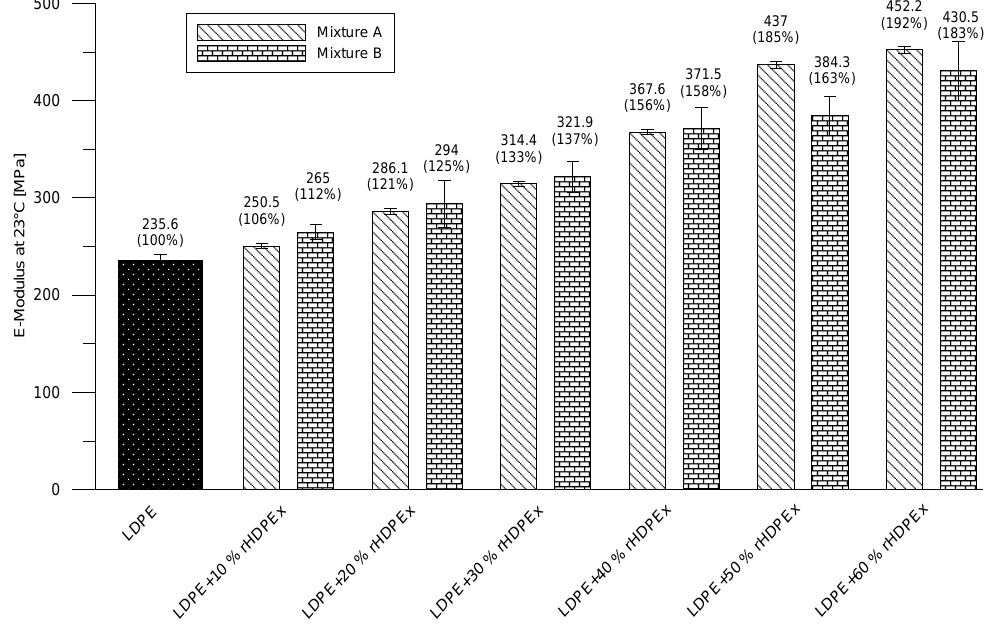
Figure 4. E-modulus at ambient temperature—Mixtures A and